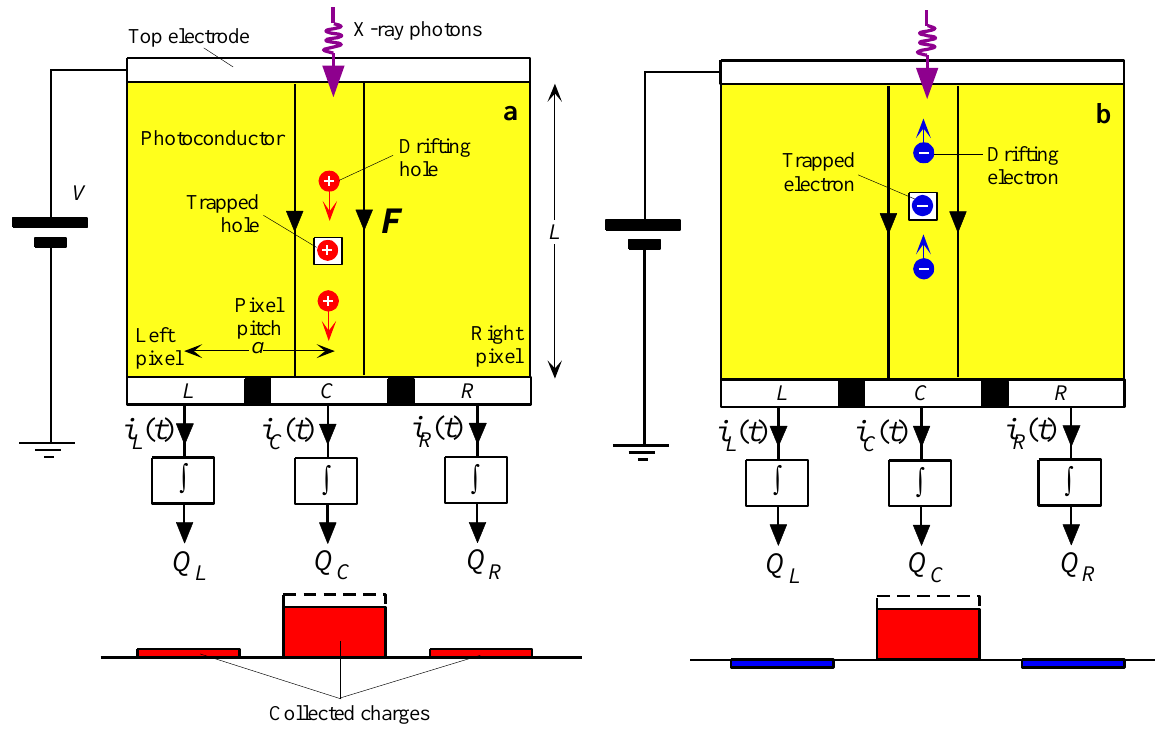
Figure 10. The effects of charge trapping on the resolution (MTF) depends on the type of carriers that have been trapped; whether carriers were drifting to the top or bottom electrode. C is the central (reference) pixel and L and R are the neighboring left and right pixels. The transient currents flowing into the pixels are integrated and eventually yield the collected charges at the